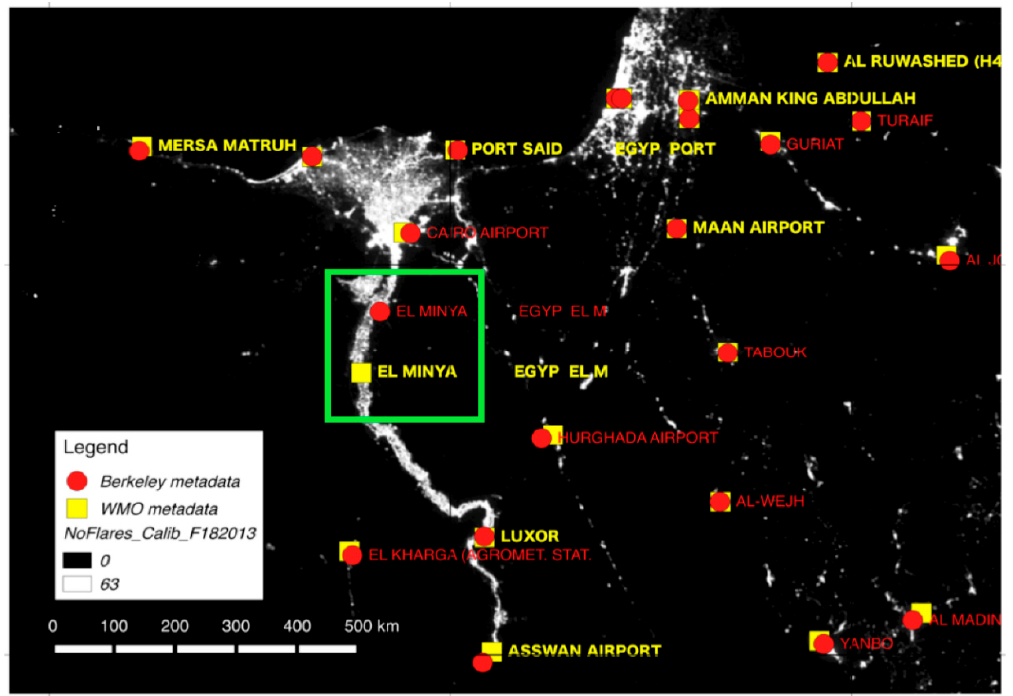
Figure 2. Application of the geo-localization procedure of air temperature stations in the Nile Delta region. Metadata provided by WMO and Berkeley Earth datasets are compared. In some cases, coordinates differ, see e.g., El Minya station (i.e., green square).